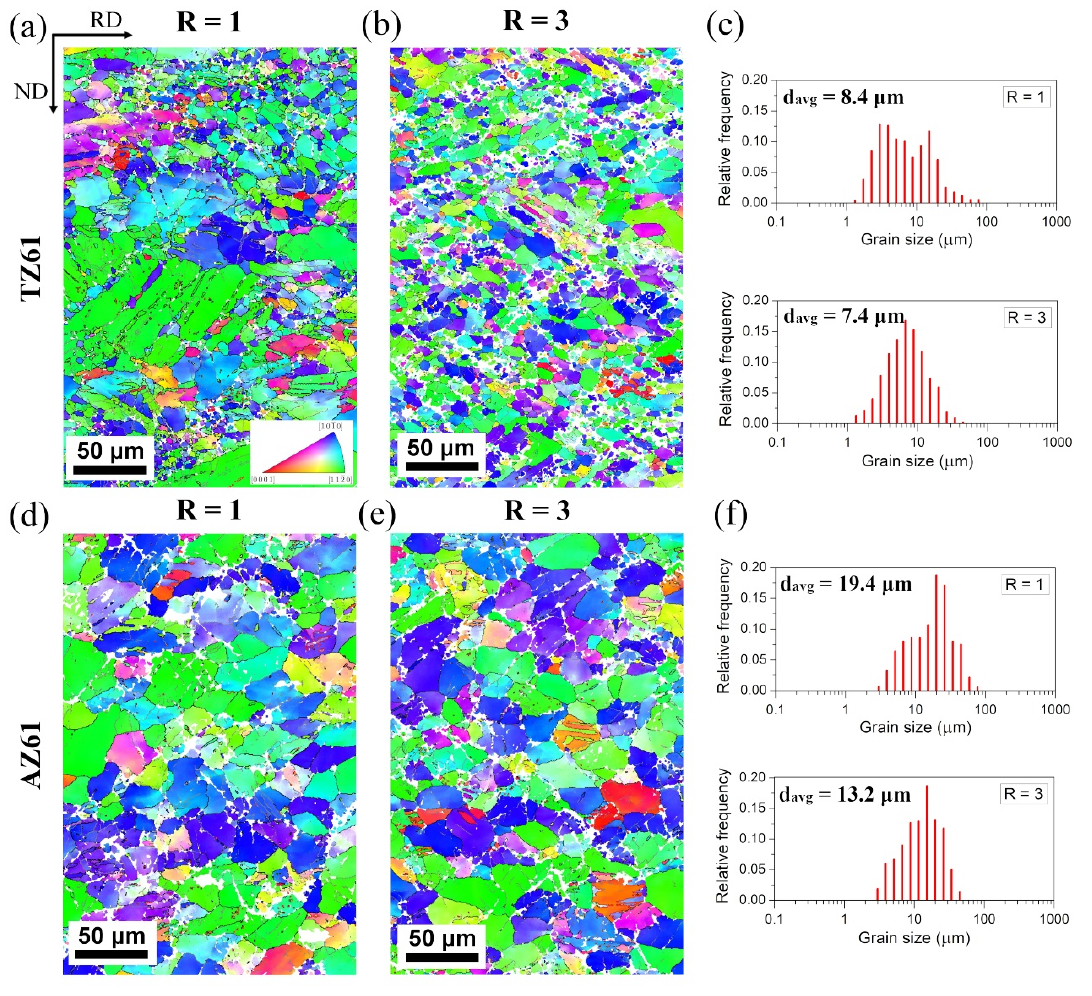
Figure 1. EBSD inverse pole figure (IPF) maps and grain size distributions of the as-rolled ( a – c ) TZ61 and ( d – f ) AZ61 sheets processed at speed ratio of: ( a , c ) R = 1 and ( b , d ) R = 3.